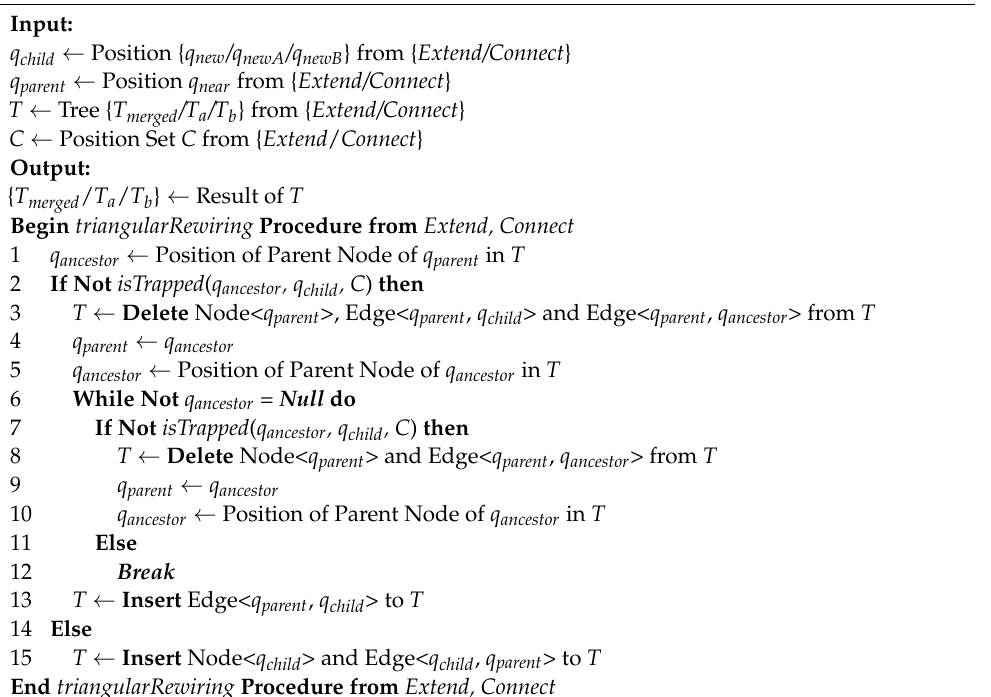
Algorithm 4 Pseudocode of the Proposed ‘Triangular-Rewiring’ Method for the